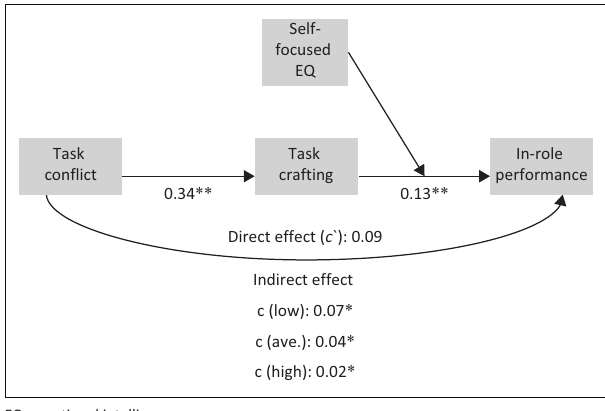
FIGURE 5: Conceptual model 1 showing second-stage moderated